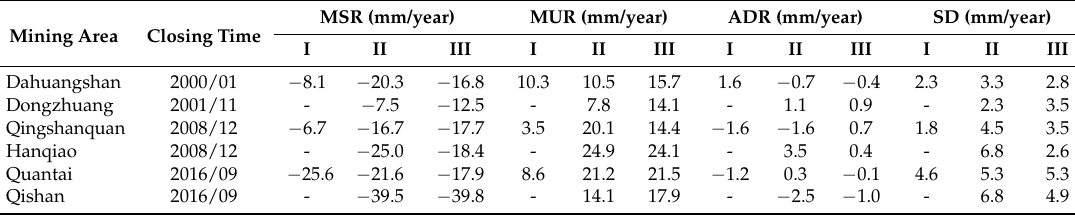
Table 3. Statistical information of deformation of each mining